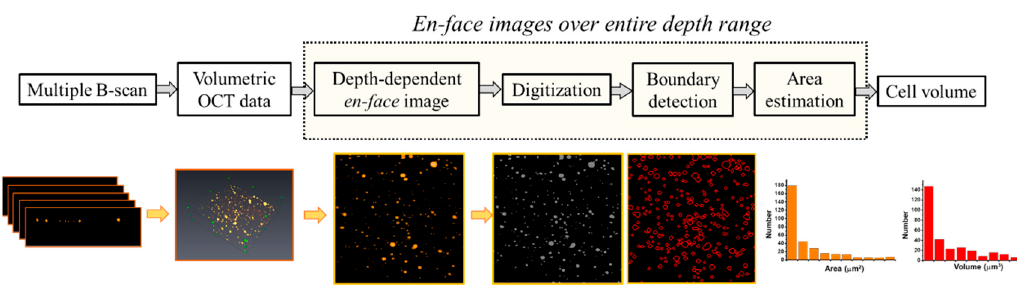
Figure 3. Flowchart of the image processing algorithm for estimation of colony volume.